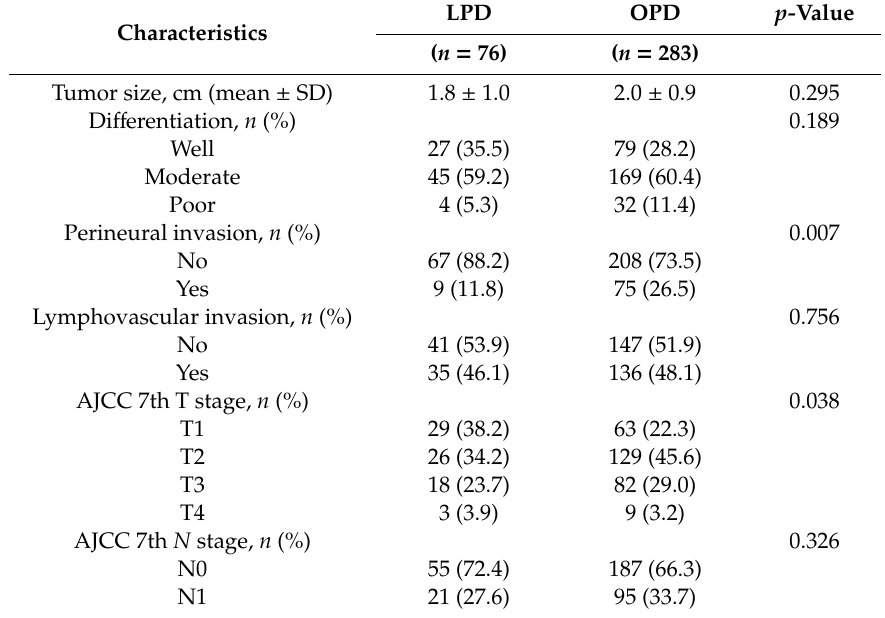
Table2. Pathologicfindingsofallunmatchedpatientswhounderwentlaparoscopicpancreaticoduodenectomy (LPD) or open pancreaticoduodenectomy (OPD).